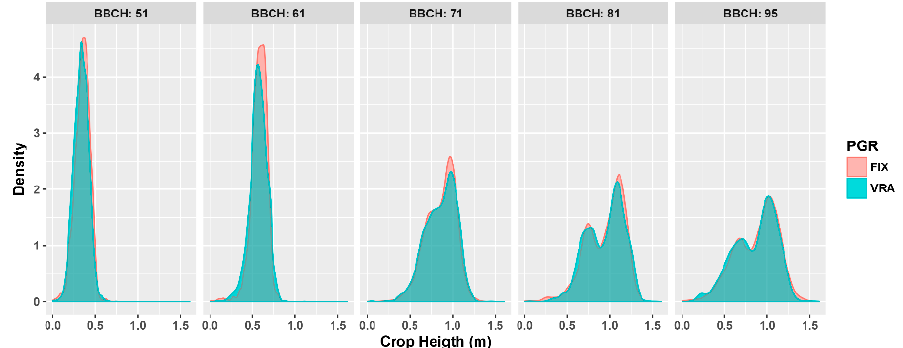
Figure 6. Frequency distribution of crop height in field NF2 under fixed-rate and variable-rate application of plant growth regulators.